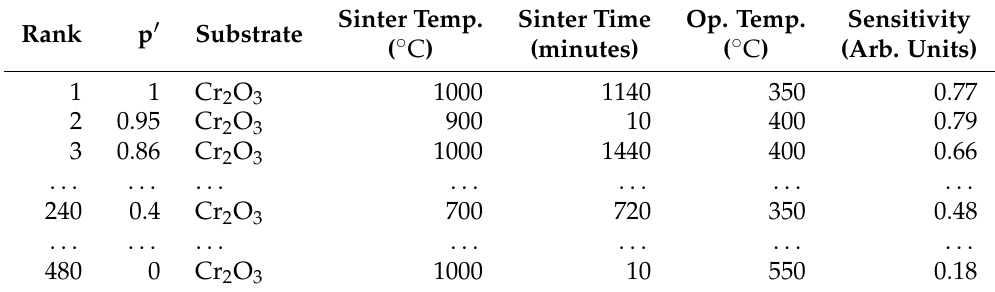
Table 5. The top 3, midfield and worst sensors from the available validated dataset ranked according to the most power-efficient (coldest sensor operation) detection of the analyte Acetone.